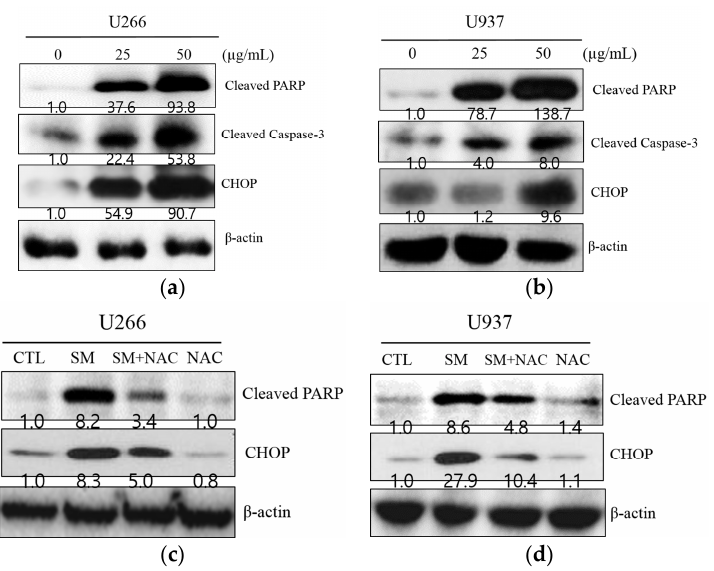
Figure 4. NAC reverses the expression of C/EBP homologous protein (CHOP) and cleavage of PARP in U266 and U937 cells. ( a ) U266 cells were treated with SM (25 or 50 µg/mL) for 24 h, and Western blot analysis was performed for cleaved PARP, cleaved caspase-3, and CHOP; ( b ) U937 cells were processed under the same conditions; ( c ) U266 cells were treated with SM (50 µg/mL) for 24 h with or without pre-treatment of NAC (5 mM) for 1 h. Cell lysates were prepared and subjected to Western blot analysis for CHOP and cleavage of PARP; ( d ) U937 cells were processed under the same conditions.